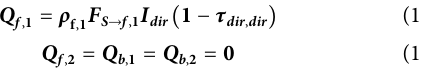
FIGURE 5 Diagram of angle factor between